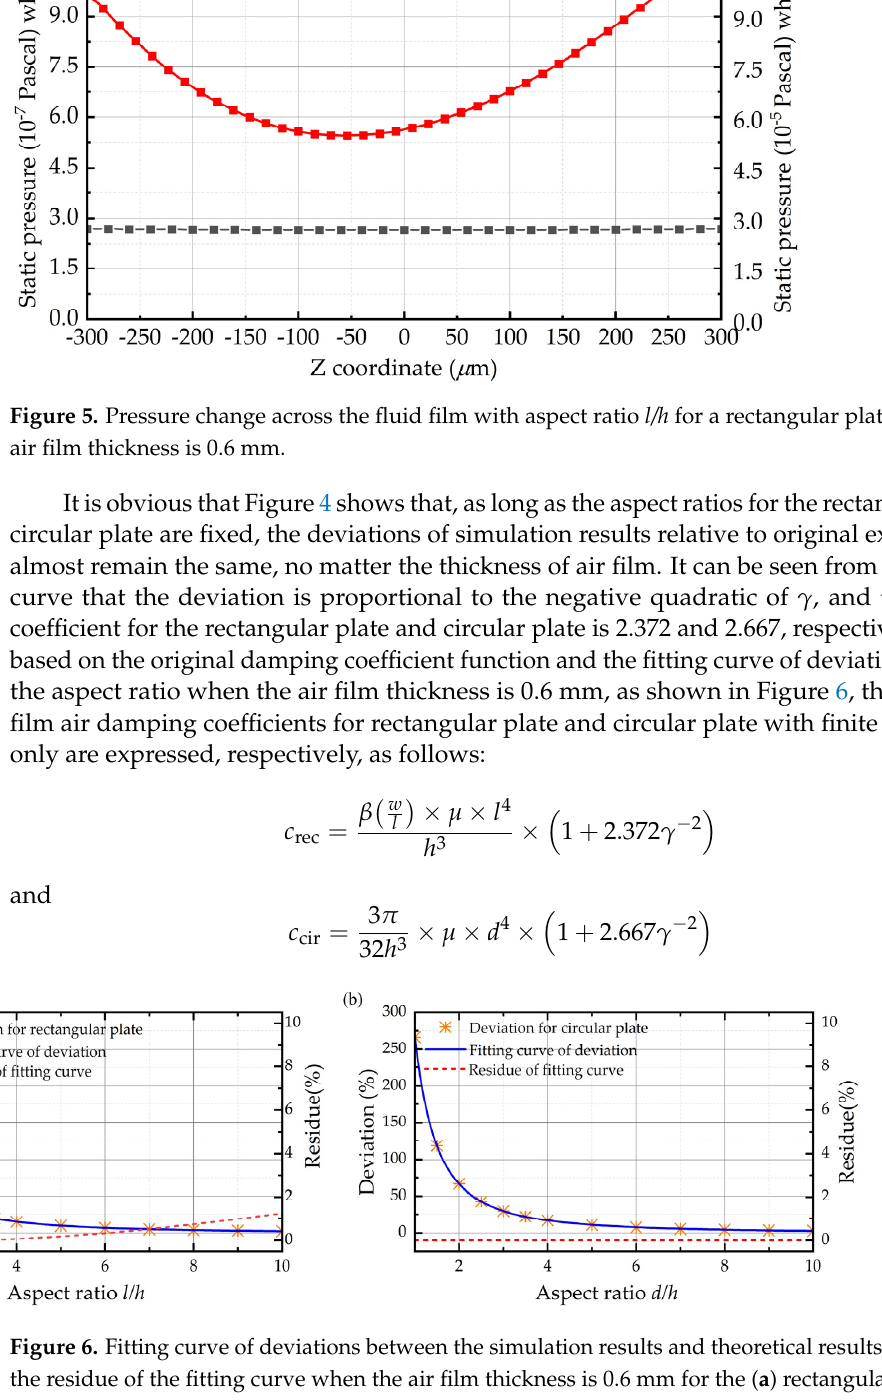
them. ( a – c ) Rectangular plate when the air film thickness is 0.06 mm, 0.6 mm, and 6 mm from top to the bottom. ( d – f ) Circular plate when the air film thickness is 0.06 mm, 0.6 mm, and 6 mm from top to the bottom.